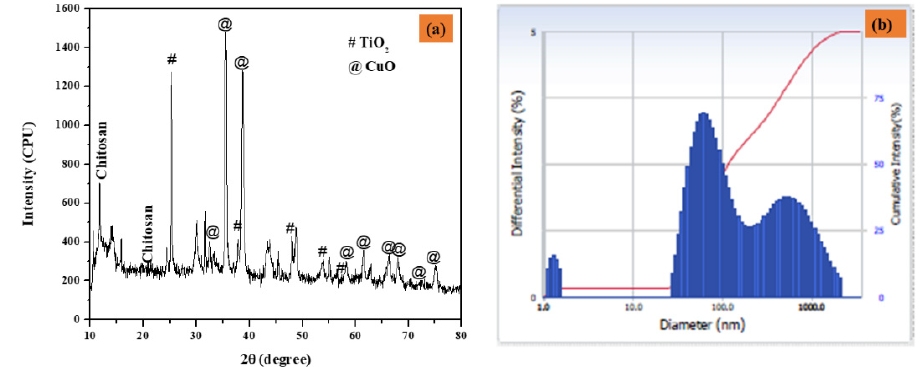
Figure 2. The XRD pattern of nanocomposites ( a ) and particle size distribution as a function of particle number ( b ) were calculated using DLS.